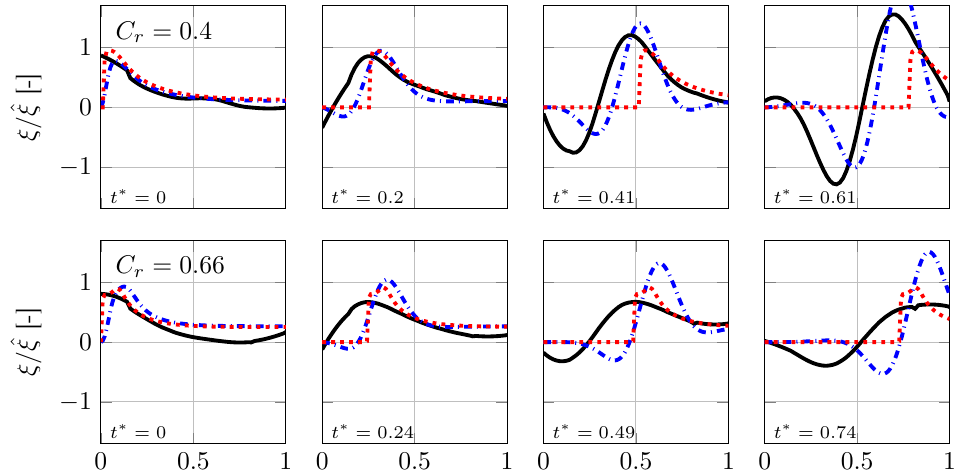
Figure 10. Four snapshots taken at equidistant instances in time of the normalized flame displacement plotted over x / L f resulting from an impulsive velocity forcing at t ∗ = 0 for confinement ratios (cid:107) C r = 0.4 ( top ) and C r = 0.66 ( bottom ). CFD results ( ); UD model ( ); BD model ( ).